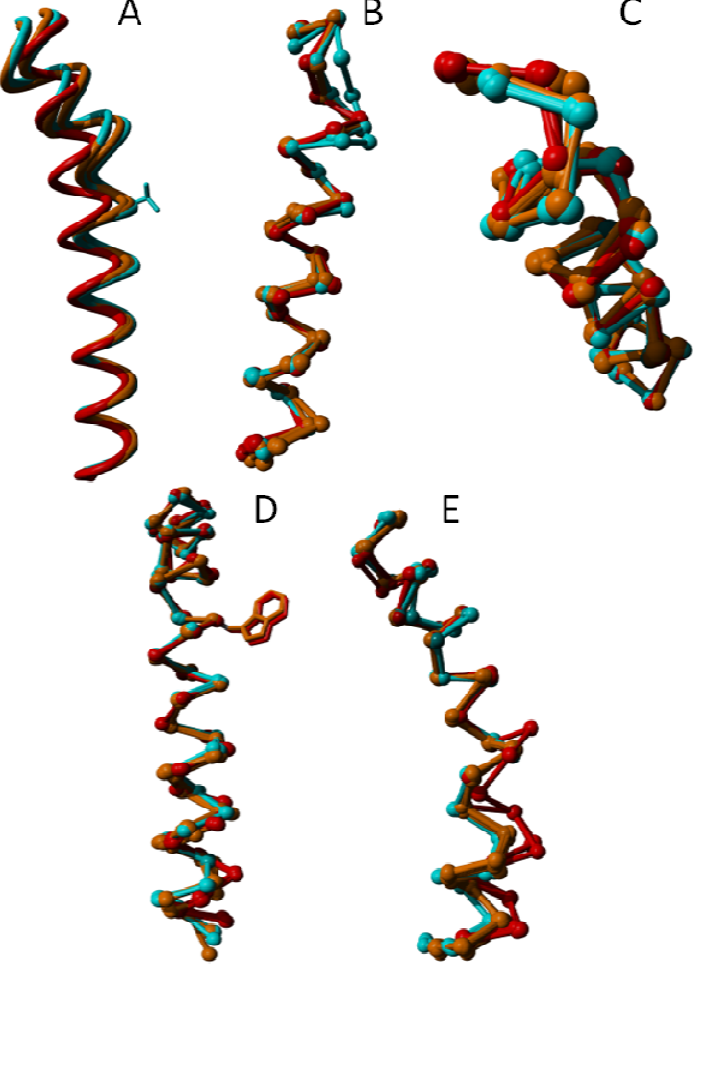
Figure 14. Local superposition results of A2A adenosine receptor transmembrane